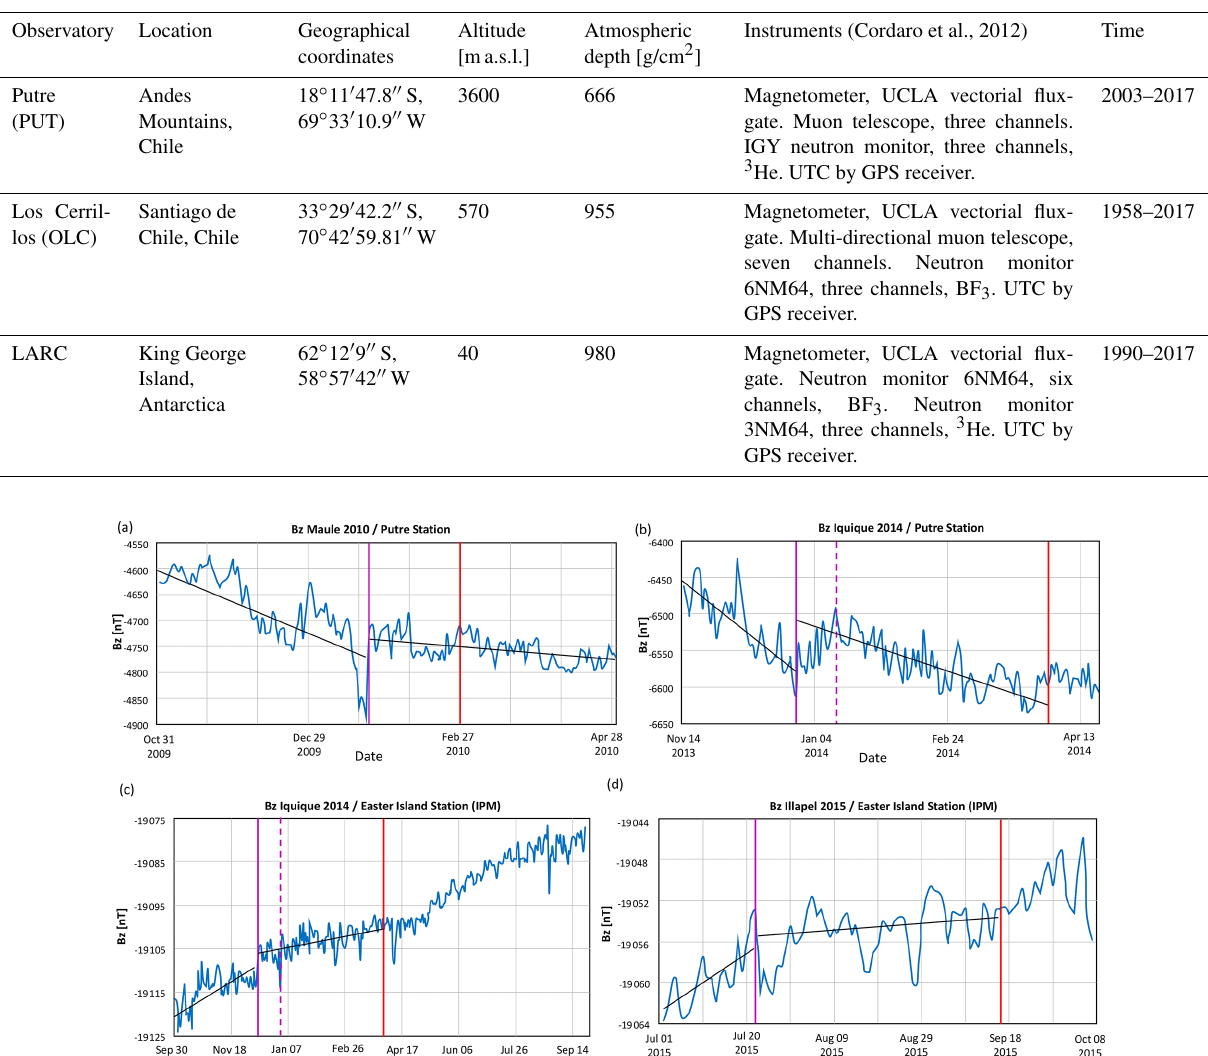
Table 1. The main characteristics for the detectors of Chilean network of cosmic rays and geomagnetic observatories: location, altitude, atmospheric depth, and types of detector (Cordaro et al., 2012).